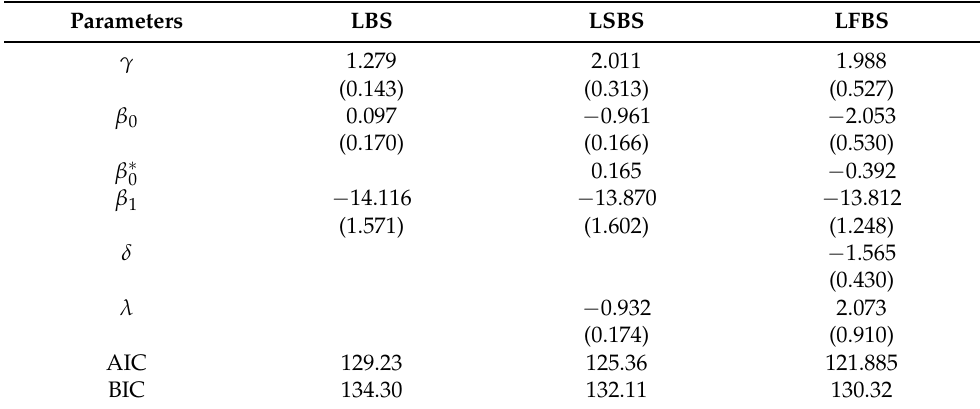
Table 4. MLEs in LBS, LSBS and LFBS